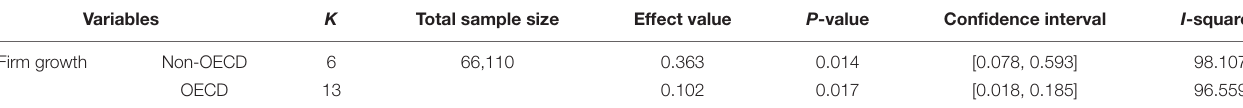
TABLE 5 | Moderating effect of the country-specific factors.